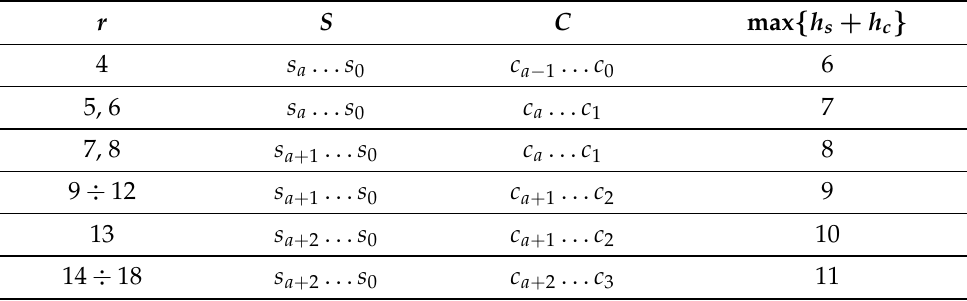
Figure 2. Detailed structure of the n -operand modular adder (MOMA) mod M . Table 3. Outputs of the n -operand CSA tree of the MOMA from [32].